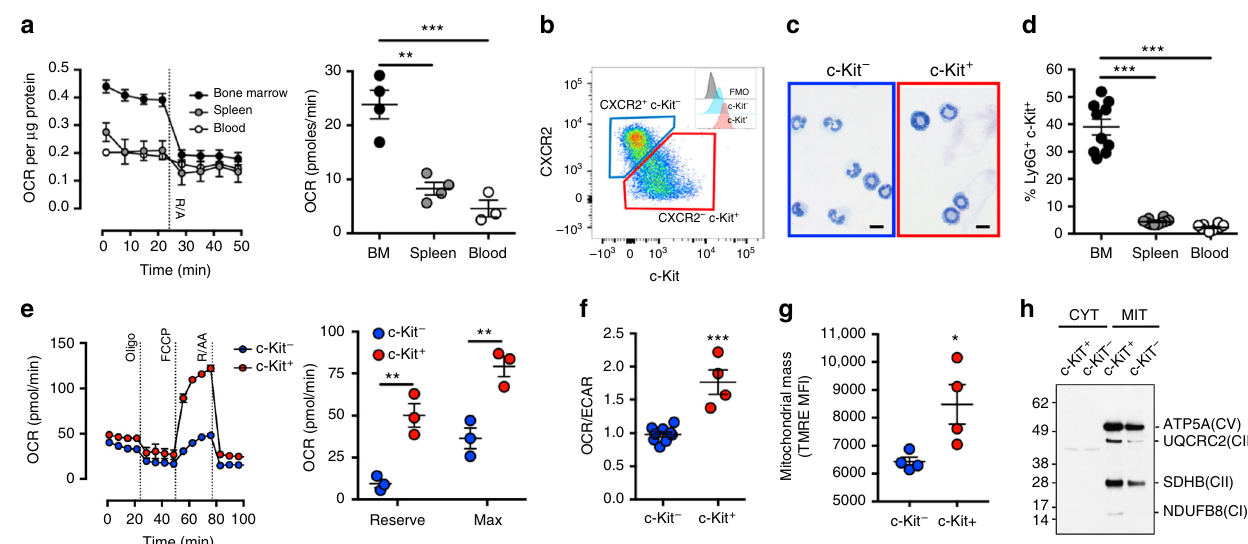
Fig. 1 c-Kit is a marker of immature oxidative neutrophils. a Determination of C57BL/6J neutrophil basal mitochondrial oxygen consumption rates (OCR, left) following inhibition of electron transport chain components (Rotenone 100 nM and antimycin A 1 µ M). Quanti fi cation of basal mitochondrial OCR from multiple independent experiments (right). Data were analysed by one-way ANOVA with Tukey ’ s post-tests indicated. Bone marrow and spleen n =